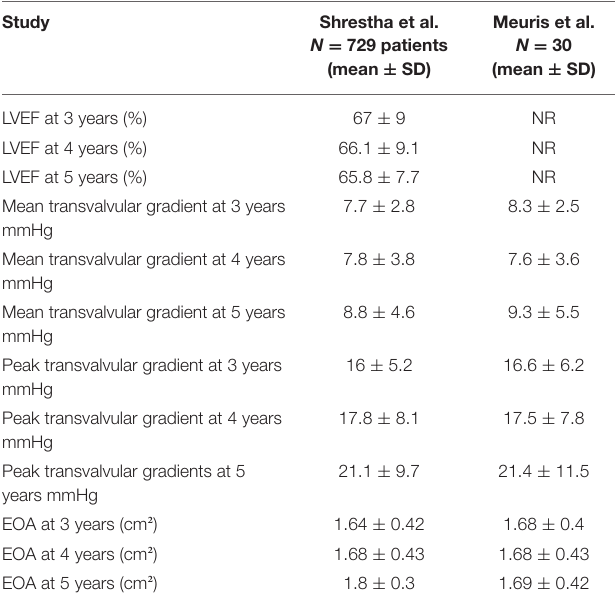
TABLE 6 | Long-term echocardiographic outcomes (5-year follow-up) of the Perceval bioprosthesis.